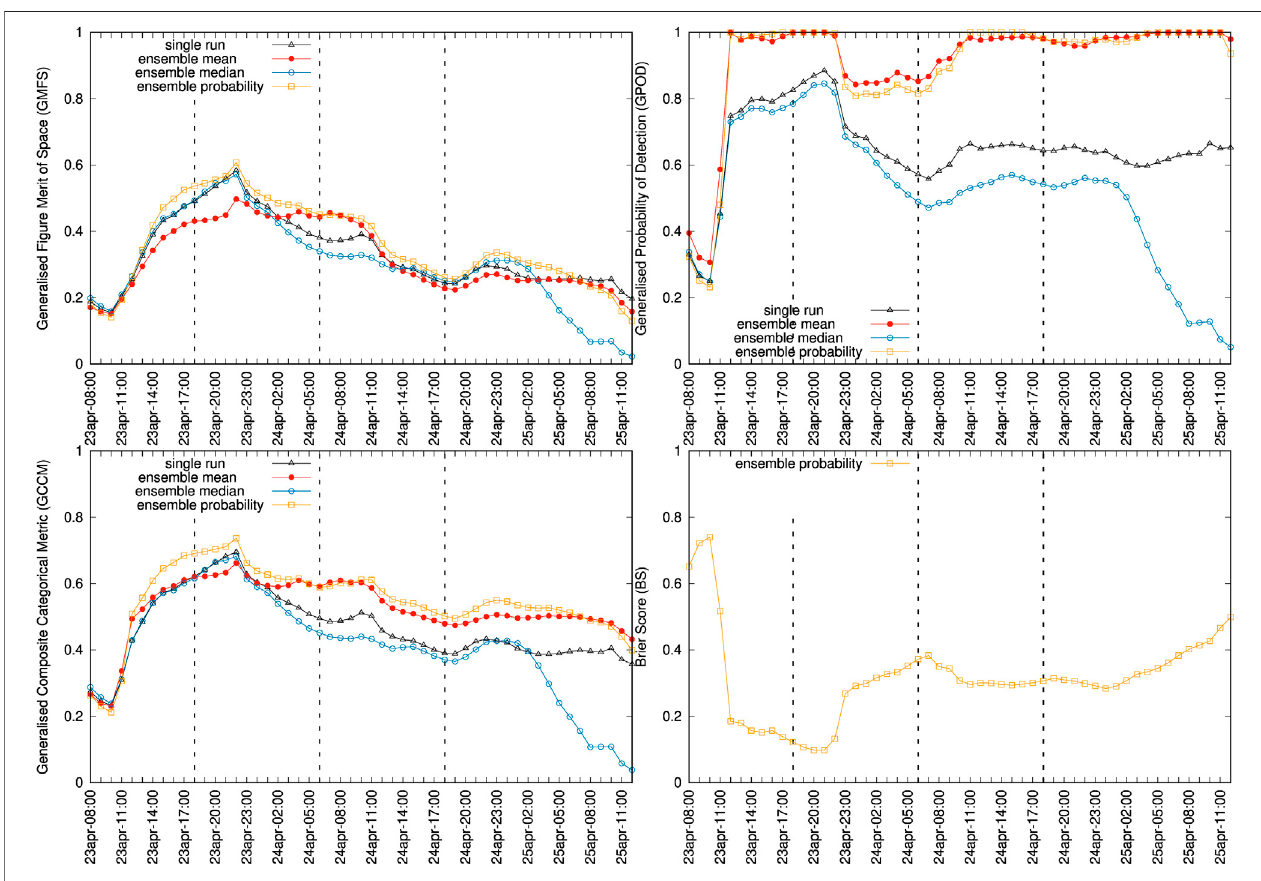
FIGURE 10 | Time series of generalised categorical metrics for deterministic (single run and ensemble-based) and probabilistic forecasts using the 0.1 g/m 2 ash columnmasscontours.PlotsshowGFMS (topleft) ,GPOD (topright) ,GCCM (bottomleft) andBS (bottomright) .SymbolsindicatetheinstantsofSEVIRIretrievals. The vertical dashed lines mark the three instants plot in Figure 9 . Note that for the BS only the probabilistic option applies.